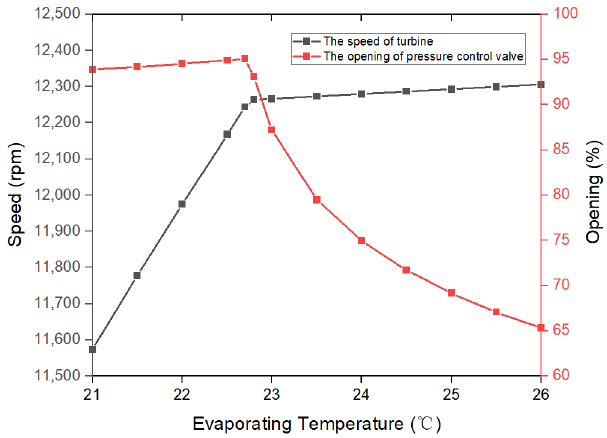
Figure 6. The speed of the turbine and the opening of the pressure control valve.